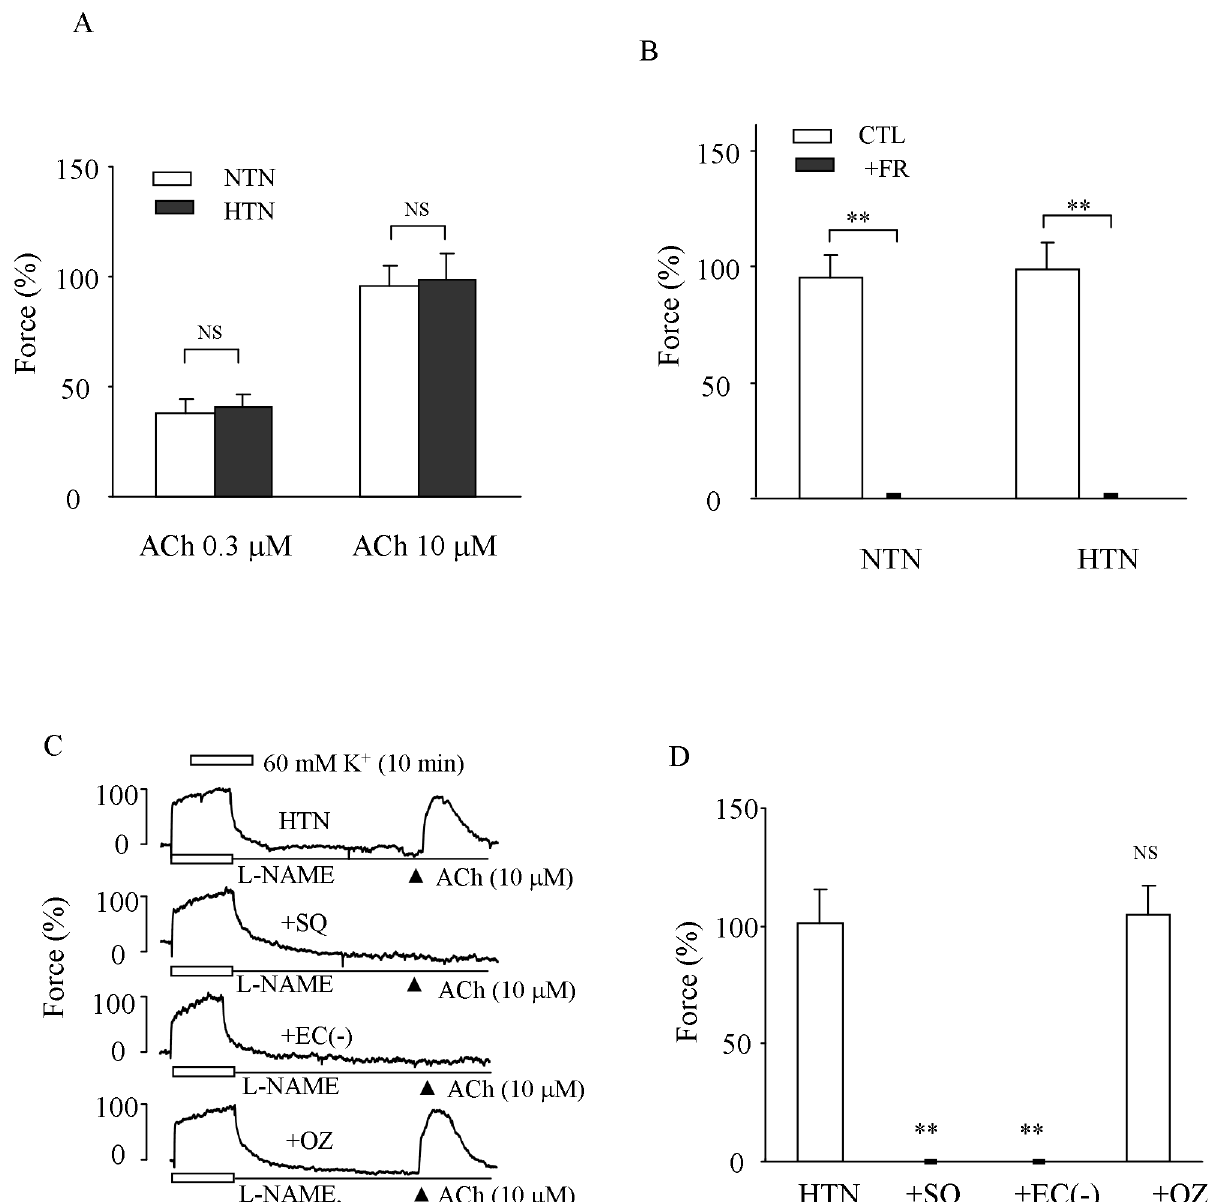
Fig 2. Response to ACh in HTN carotid arteries with NO synthase inhibited. A : summary of contractions evoked by 0.3 and 10 μ M ACh in HTN and NTN arteries treated with 1 mM L-NAME. B : comparison of contractions evoked by 10 μ M ACh in NTN and HTN vessels with those obtained in the presence of 1 μ M FR122047 (+FR). C : representative traces showing the control response evoked by ACh (10 μ M) in L-NAME-treated HTN arteries (top), the response obtained in the presence of 3 μ M of TP receptor antagonist SQ29548 (+SQ; 2 nd trace), and that in vessels denuded of the endothelium (+EC-; 3 rd trace)